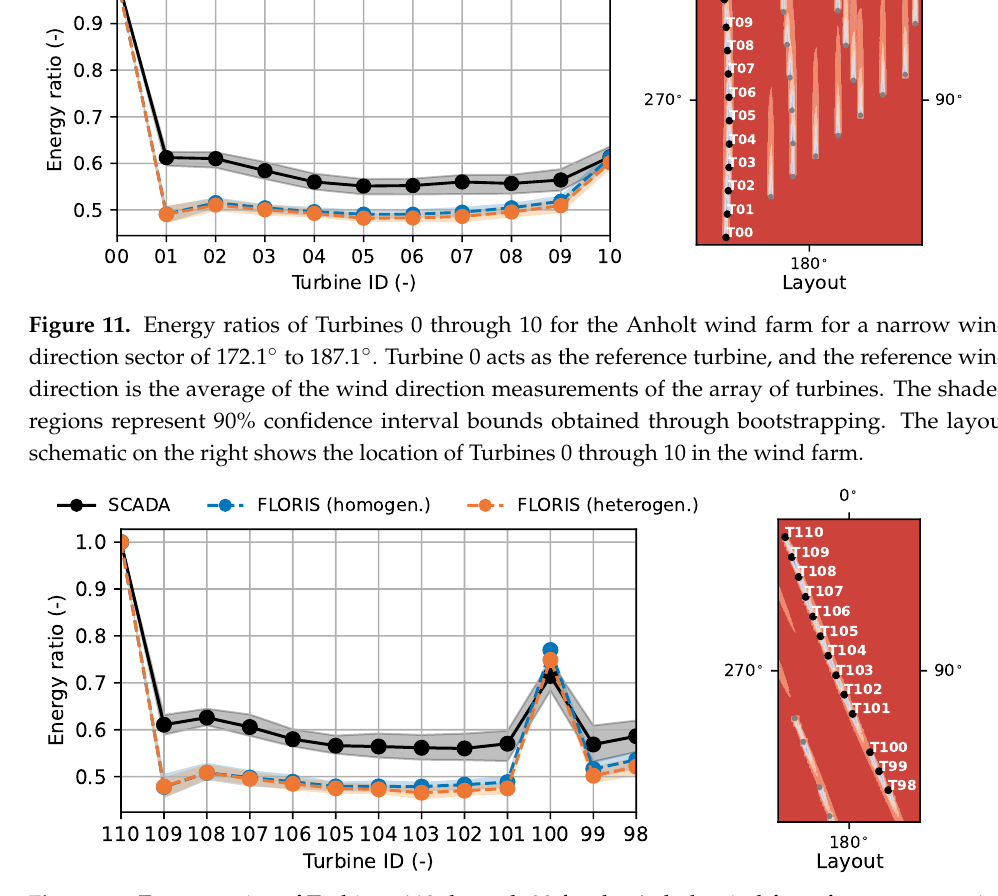
Figure 12. Energy ratios of Turbines 110 through 98 for the Anholt wind farm for a narrow wind direction sector of 330.3 ◦ to 345.3 ◦ . Turbine 110 acts as the reference turbine, and the reference wind direction is the average of the wind direction measurements of the array of turbines. The shaded regions represent 90% confidence interval bounds obtained through bootstrapping. The layout schematic on the right shows the location of Turbines 110 through 98 in the wind